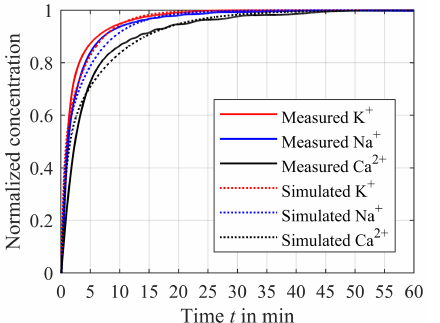
Figure 10. Comparison between the measured step response (solid lines) and the simulated response (dotted lines) for potassium (red line), sodium (blue line) and calcium (black line). The distance h s between the ISEs and compartment membrane is about